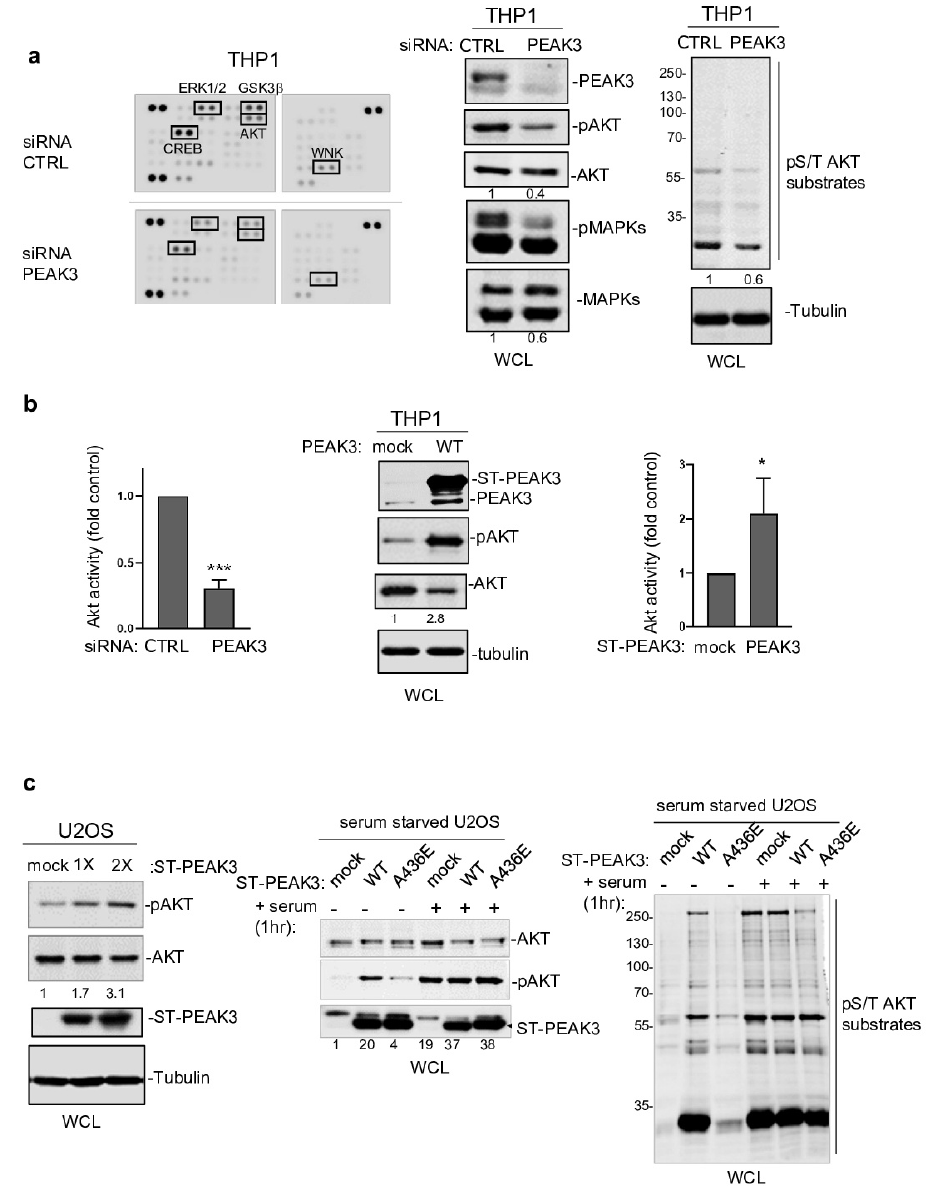
Figure 4. PEAK3 activates AKT signaling in the absence of growth factors. ( a ) (left) Phospho-kinase array analysis of THP1 cells transfected with siRNA control (CTRL) or siRNA against PEAK3. The phospho-signal reduction in the siRNA PEAK3 condition is highlighted (i.e., pT202/Y204 ERK1/2; pS21/9 GSK3 β ; pS133 CREB; pS473 AKT; and pT60 WNK). (right) Western blot analysis of MAPK, AKT activity, and signaling (pS/T AKT substrates level). Tubulin level and relative AKT and MAPK activity is shown. ( b ) (left) Quantification of AKT inhibition upon PEAK3 silencing (mean ± SD; n = 3); *** p < 0.001 (Student’s t test) (bottom). PEAK3 overexpression increases AKT activity in THP1 cells. A representative western blot (middle) and relative quantification of AKT activation (right) (mean ± SD; n = 3); * p < 0.05 (Student’s t test). ( c ) PEAK3 expression induces AKT signaling in U2OS cells, even in the absence of growth factors. (left) AKT activation and its relative quantification upon transient PEAK3 expression (1 × : 1 µ g, 2 × : 2 µ g of PEAK3 construct transfected) ( n = 2). SHED-dependent PEAK3 activation of AKT signaling in the absence of growth factors. U2OS cells that stably express WT or A436E PEAK3 were serum-starved for >20 h and stimulated or not with 10% FCS for 1 h. Then, the levels of AKT, phosphorylated AKT (middle), and pS/T AKT substrates were assessed (right) ( n = 2).